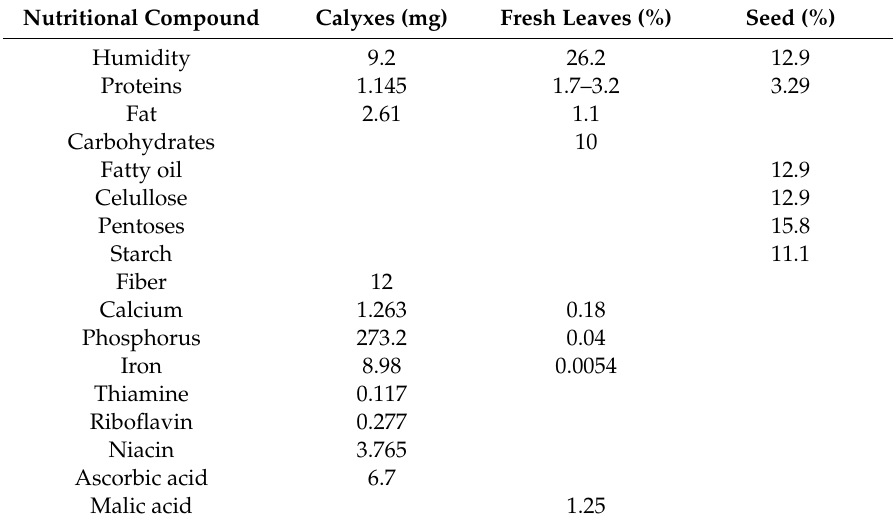
Table 1. Nutritional compounds of Hibiscus sabdari ff a